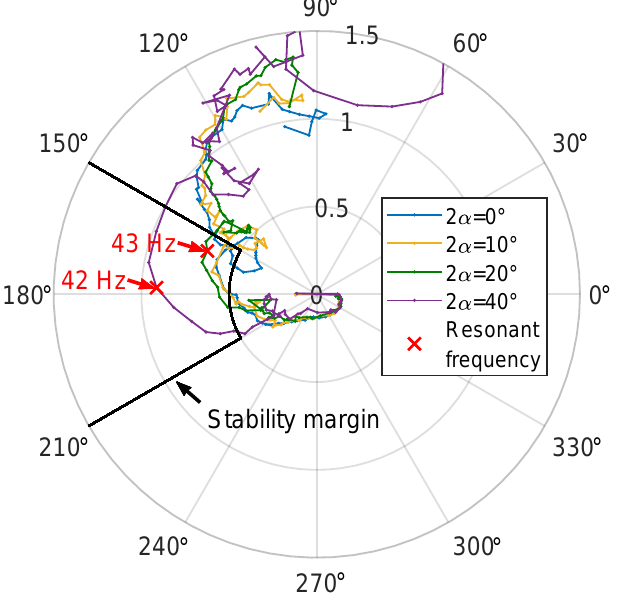
Figure 8. Polar plot of dominant Eigenvalue λ 1 of the return ratio matrix for different values of overlap